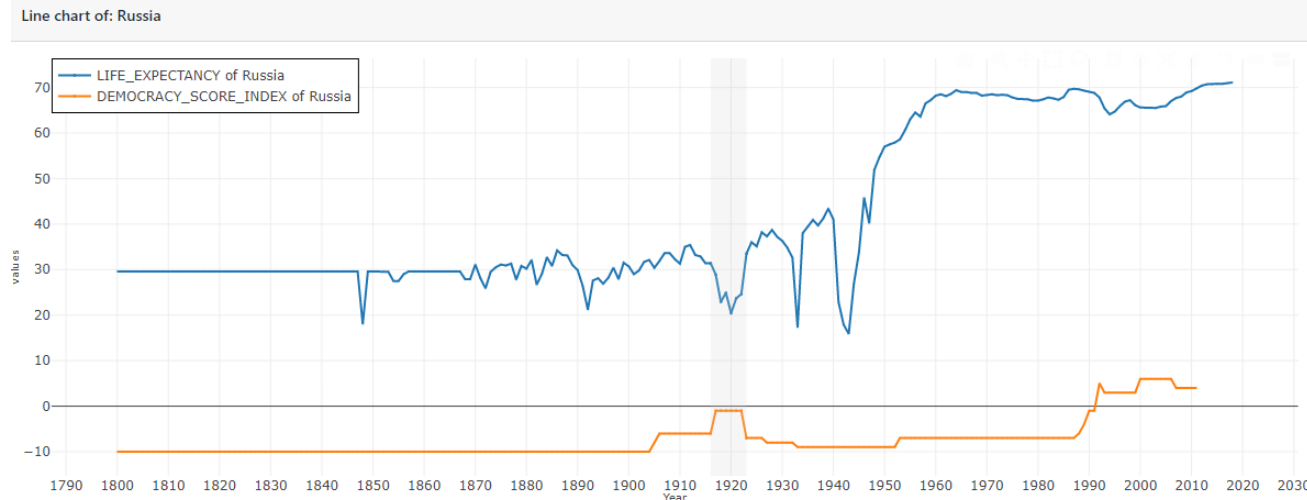
Figure 8. Russia life expectancy and democracy index presents interesting